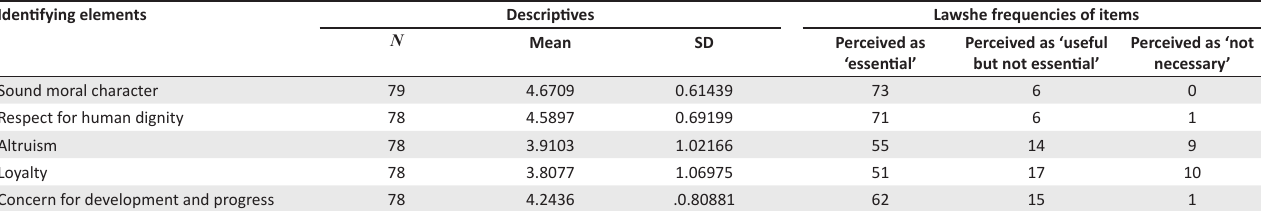
TABLE 3: Descriptive statistics of basic personal values of professionals. Identifying elements